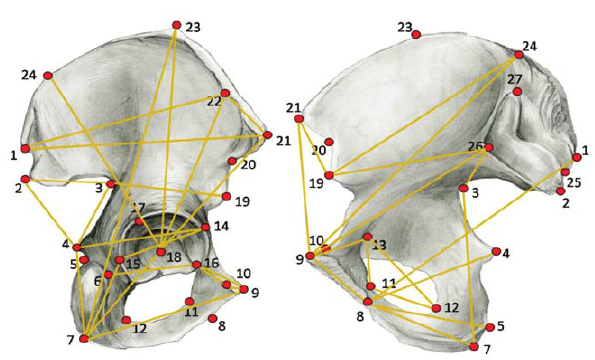
Figure 2. Landmarks and inter-landmark distances. Landmarks and linear distances used in the study are shown on right os coxae (lateral view shown on left, medial view shown on right). doi:10.1371/journal.pone.0055909.g002 (99.04% and 98.87% respectively), supporting the validity of the visual sex determination.